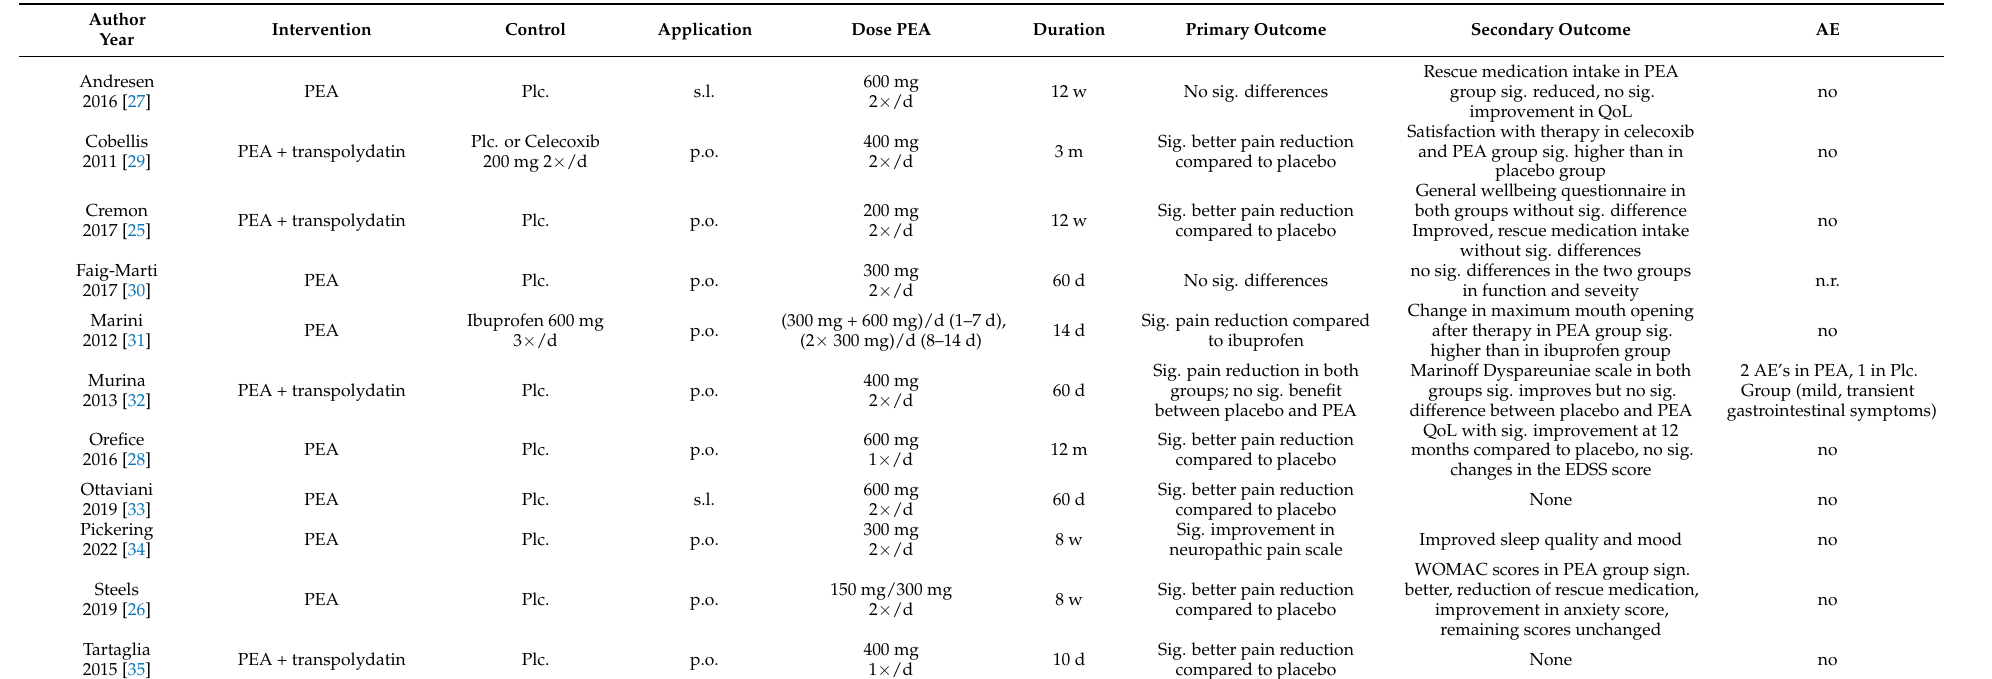
Table 4. Key outcomes of included studies